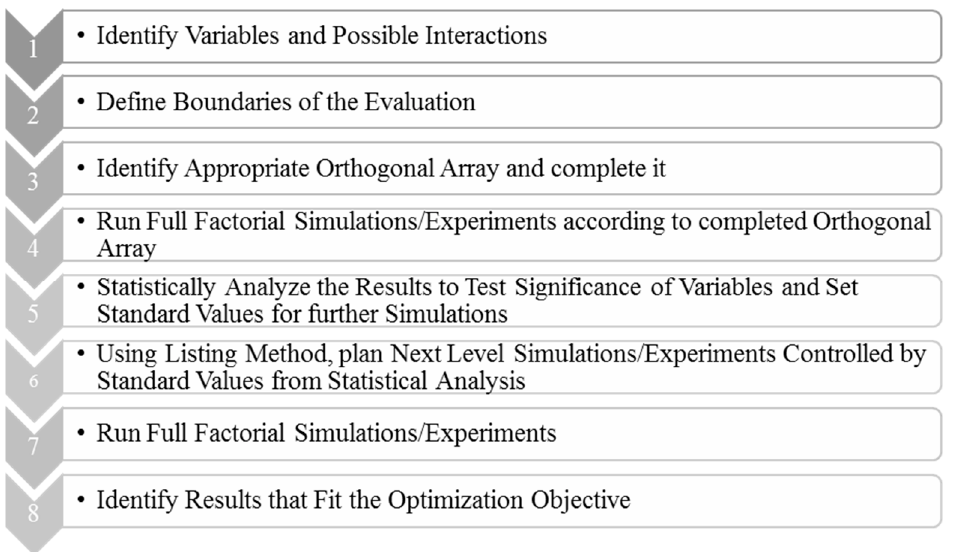
Figure 7. Flow of work when using Orthogonal Arrays Optimization Methodology.